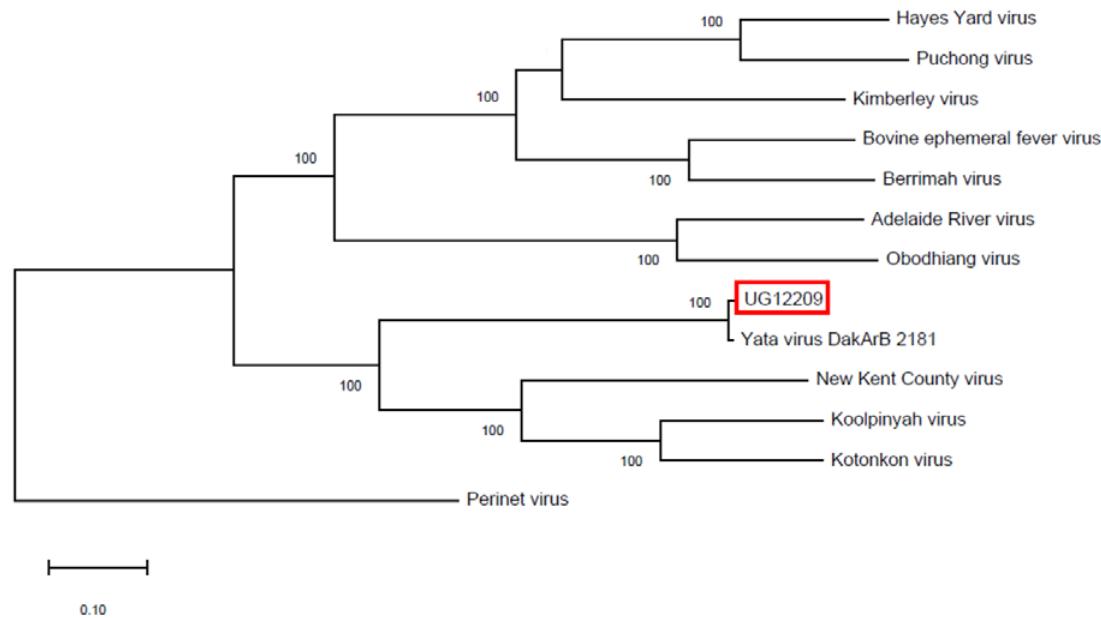
Figure 3. Nucleotide maximum-likelihood phylogenetic tree with 1000 bootstrap replications com- paring the two reported Yata virus isolates to other known ephemeroviruses and rooted with Perinet virus (genus Vesiculovirus ). The current isolate, 12209, is boxed in red. GenBank accession num-